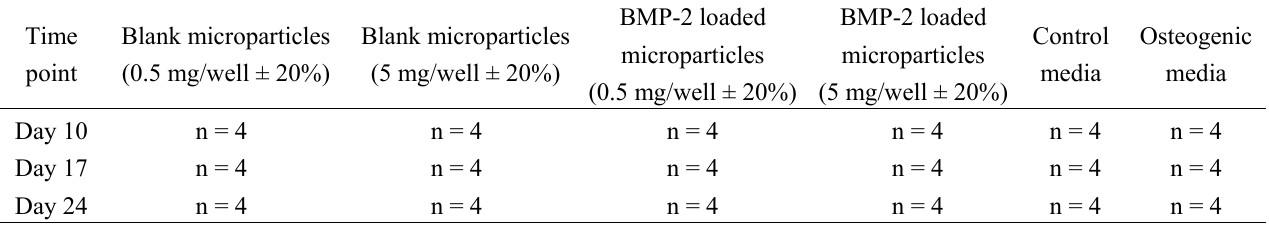
Table 1. Experimental conditions that were assessed in 2D culture in 48-well tissue culture